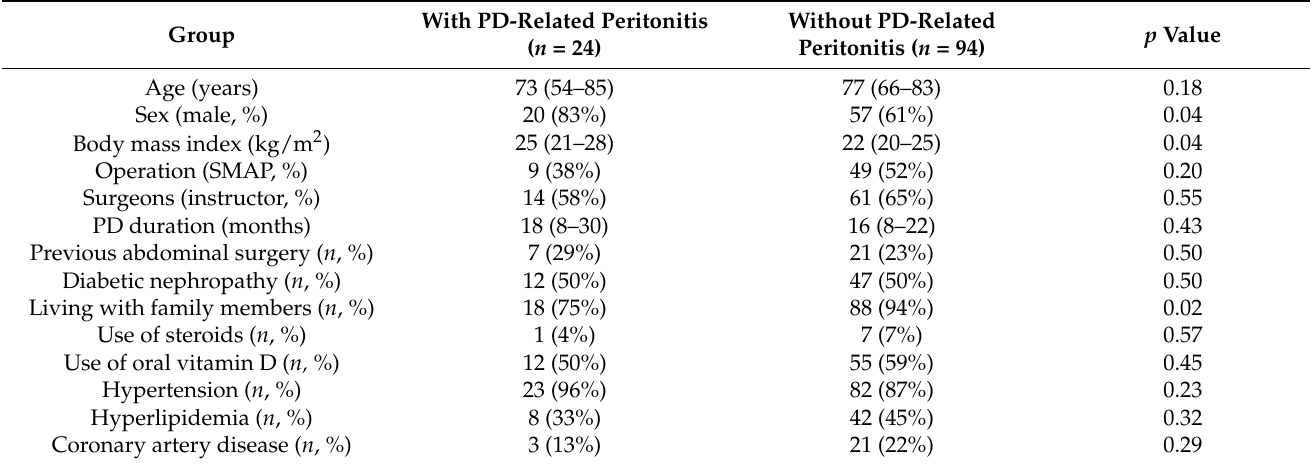
Table 2. Comparison of preoperative CT findings and laboratory parameters between patients with and without peritoneal dialysis-related peritonitis.